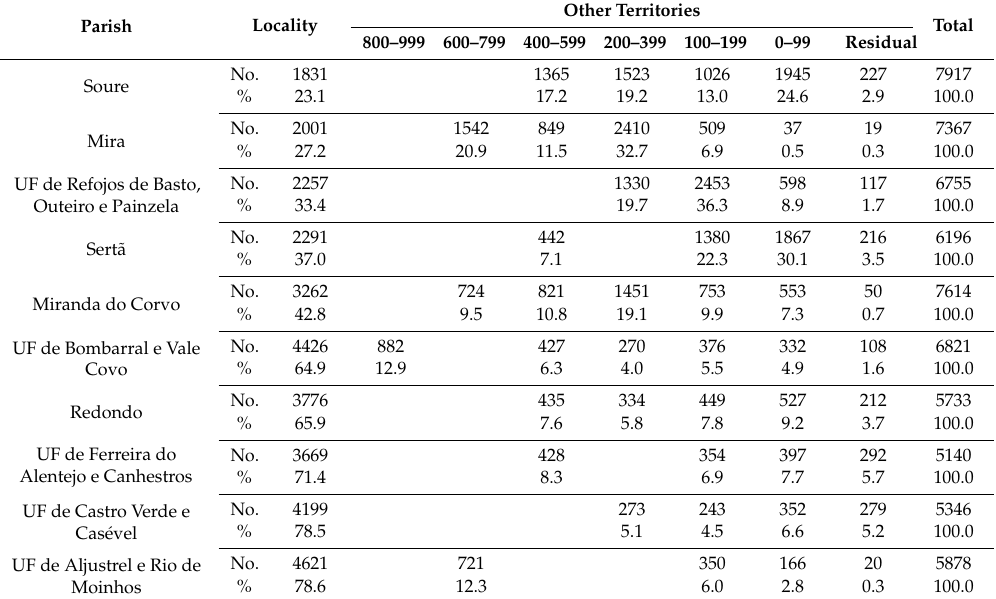
Table 5. Number and percentage of inhabitants in localities with the municipal headquarters, and other territories according to their population size, belonging to APU (TIPAU) and Code 3 (DEGURBA) parishes.